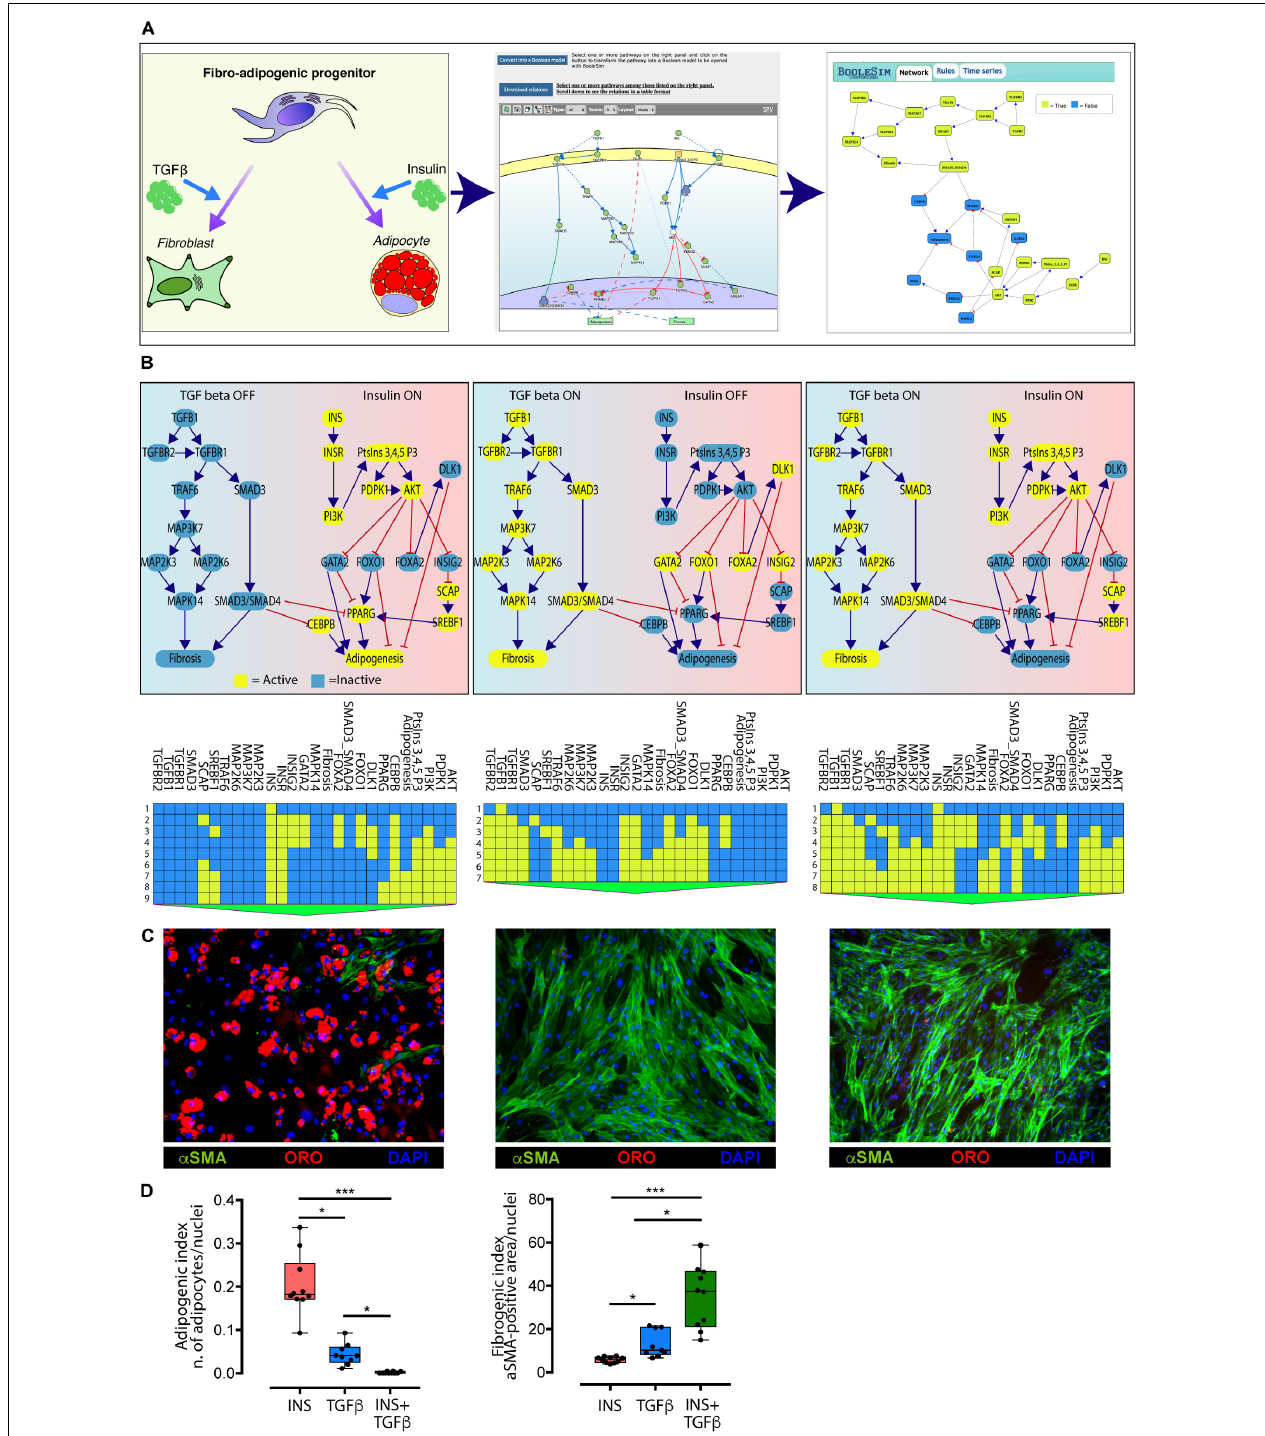
FIGURE 4 | Conversion of the TGF β and INS pathways into an executable Boolean network. (A) The ability of FAPs to differentiate into either adipocytes or fibroblasts (left panel) is represented in Myo-REG as a union of two selected pathways: INSR and TGF β (middle panel). Pathways are automatically converted into a Boolean network and input into a customized BooleSim application (right panel). Panel (B) depicts the system stationary phase in conditions in which the FAPs are stimulated with insulin (left panel), TGF beta (middle panel) or both (right panel). The network evolution is represented as a heatmap below each simulation. Yellow means active (True) while blue is inactive (False). (C) Representative immunofluorescence (20 × magnification) of FAPs from wild type mice stimulated to differentiate in the presence of insulin (left) ( n = 10), TGF beta (middle) ( n = 9) or both stimuli (right) ( n = 10). Adipocytes (red) and fibroblasts (green) were stained with oil Red